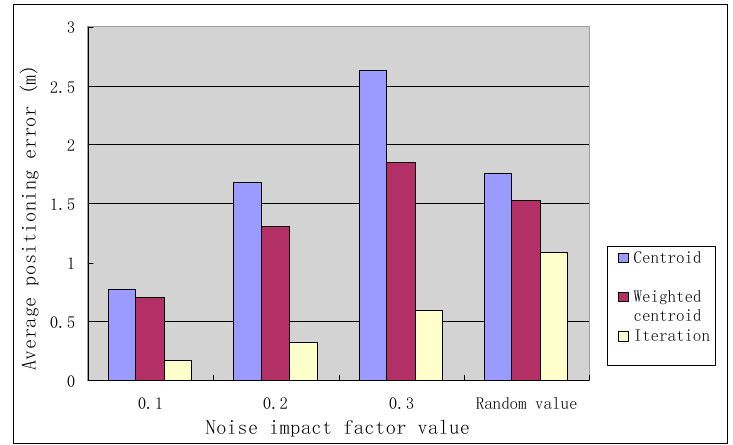
Figure 10. Positioning errors of three positioning algorithms under different noise influence factors.